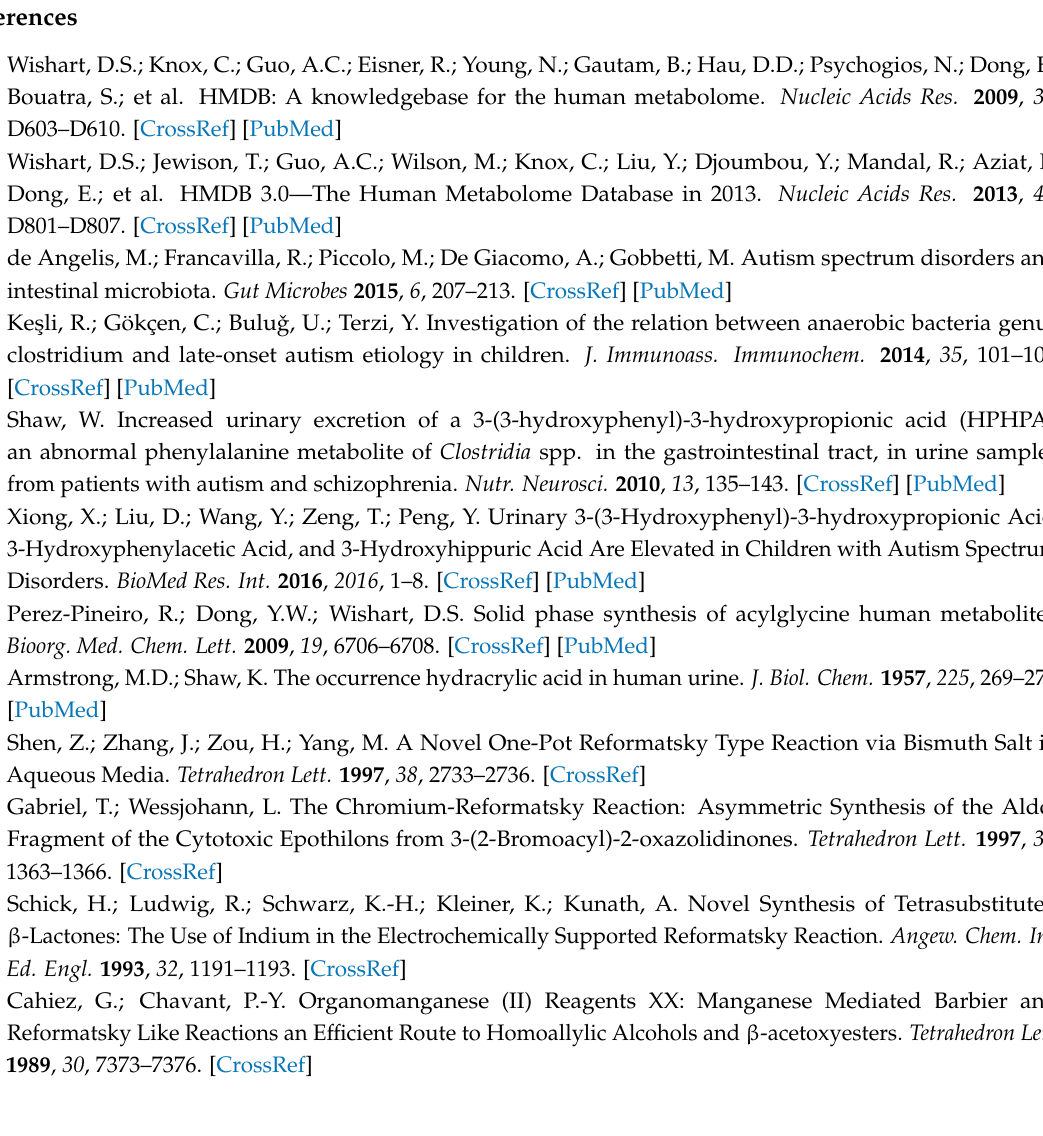
HPHPA 5 . The peak assignments are indicated with numbers on the structure, Figure S4: Representative 13 C-NMR spectra of 13 C-labeled HPHPA 5 . The peak assignments are indicated with numbers on the structure, Figure S5: HPLC chromatogram of HPHPA 4 with UV absorbance measured at 210 and 254 nm. The retention time of HPHPA was 7.04 min, Figure S6: HPLC chromatogram of 13 C-labeled HPHPA 5 with UV absorbance measured at 210 and 254 nm. The retention time of 13 C-labeled HPHPA was 7.06 min, Figure S7: HR-MS-ESI for HPHPA 4 C 9 H 10 O 4 , Figure S8: HR-MS-ESI for 13 C-labeled HPHPA 5 C 8 ( 13 C)H 10 O 4 , Table S1: Percentage area report for HPHPA 4 , Table S2: Percentage area report for 13 C-labeled HPHPA 5